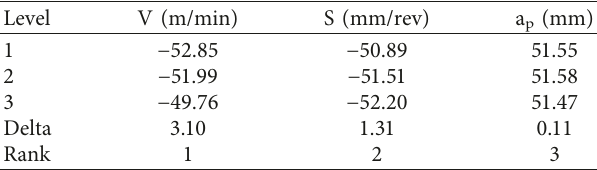
Figure 4: S/N ratio’s main effects for cutting force. Table 5: Signal to noise ratio for “F z ”: response table.